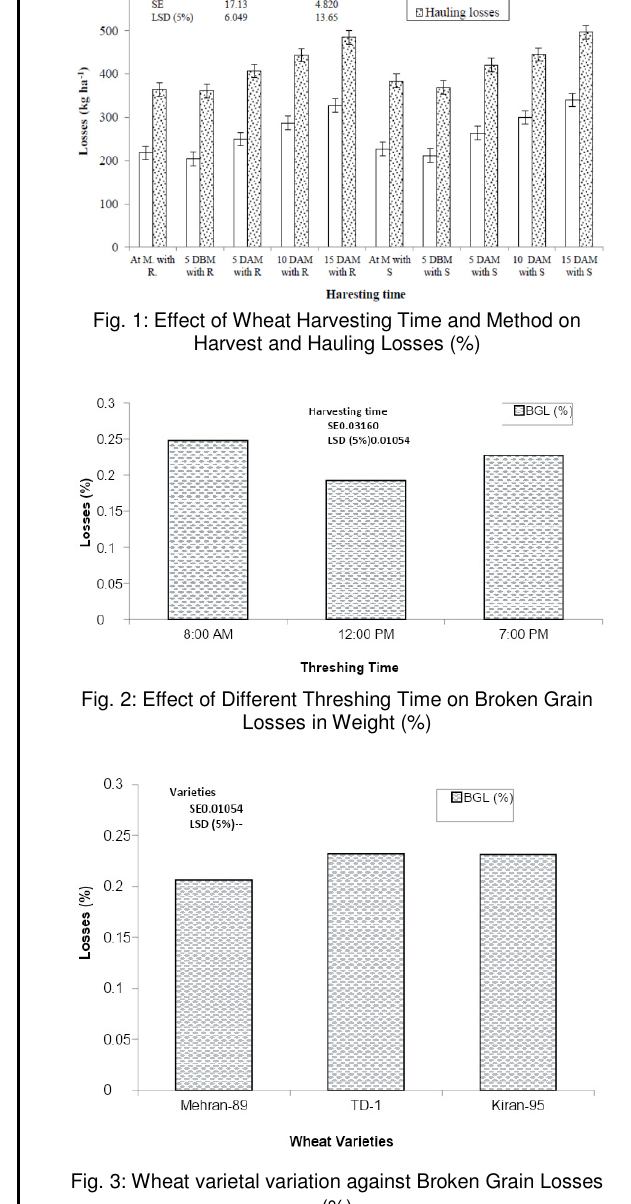
Fig. 3: Wheat varietal variation against Broken Grain Losses